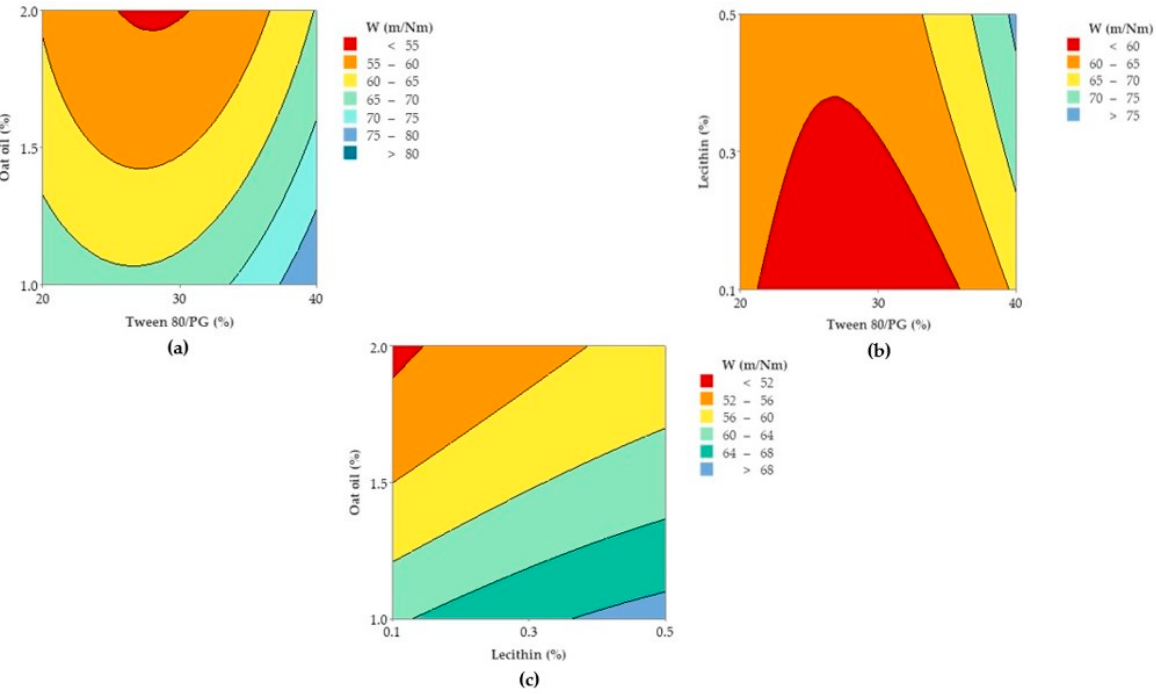
Figure 22. Contour plots representing W response (Y 3 ) variation as a function of: ( a ) Tween 80/PG (%), Oat oil (%), ( b ) Tween 80/PG (%), Lecithin (%), and ( c ) Oat oil (%), Lecithin (%).